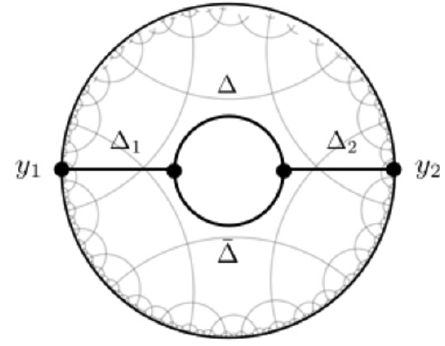
Figure 2. Scalar one-loop bubble diagram generated by the cubic couplings (2.10)